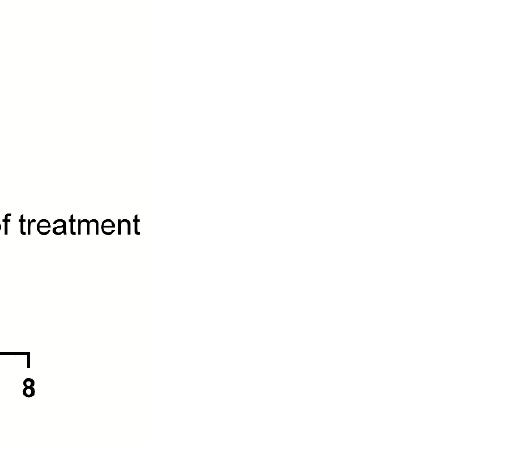
Figure 2. Improvement in serological azotemia with changes in the location of the stone observed on ultrasound.